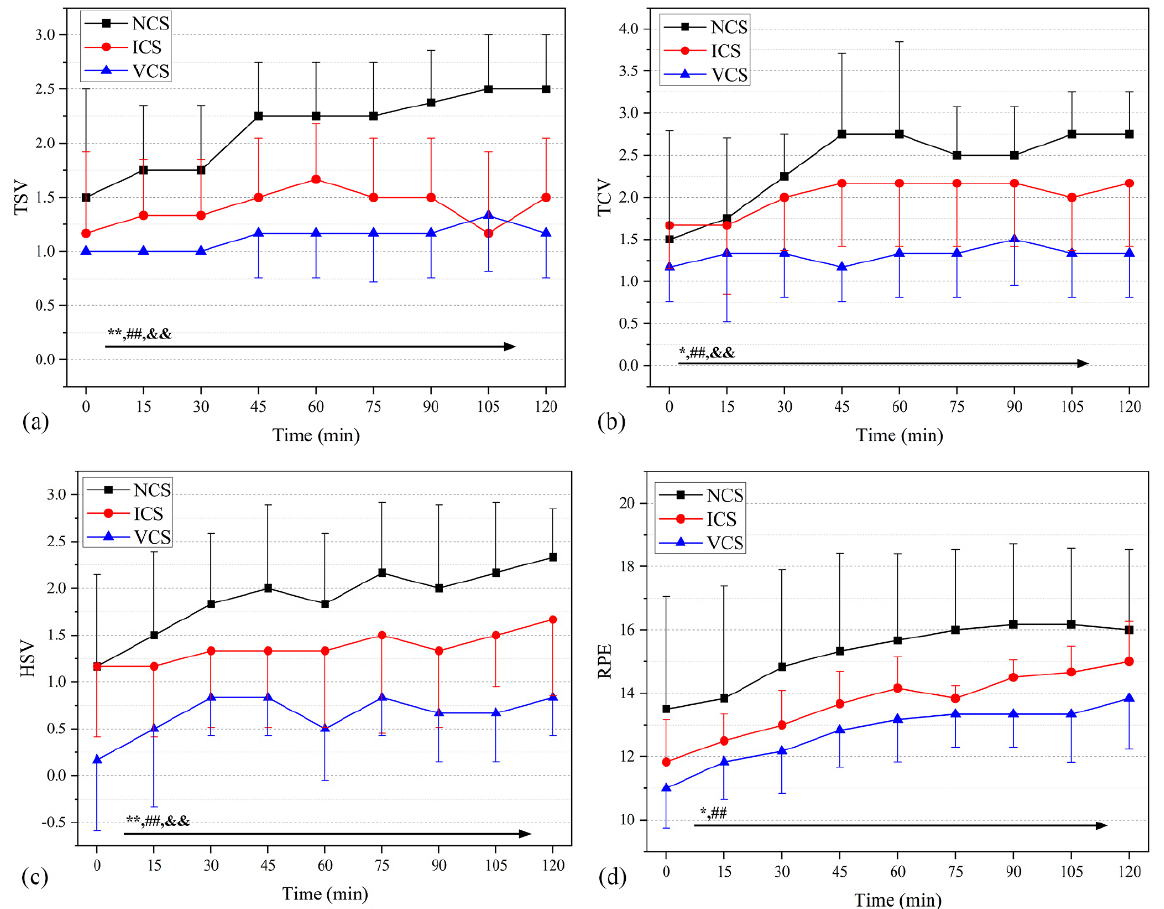
Figure 10. Comprehensive subjective evaluation voting in NCS, ICS, and VCS. ( a ) Thermal sensation votes. ( b ) Thermal comfort votes. ( c ) Humid sensation votes. ( d ) Borg’s rating of perceived exertion. *, p < 0.05, **, p < 0.001 (NCS vs. ICS); ##, p < 0.001 (NCS vs. VCS); &&, p < 0.001 (ICS vs. VCS).